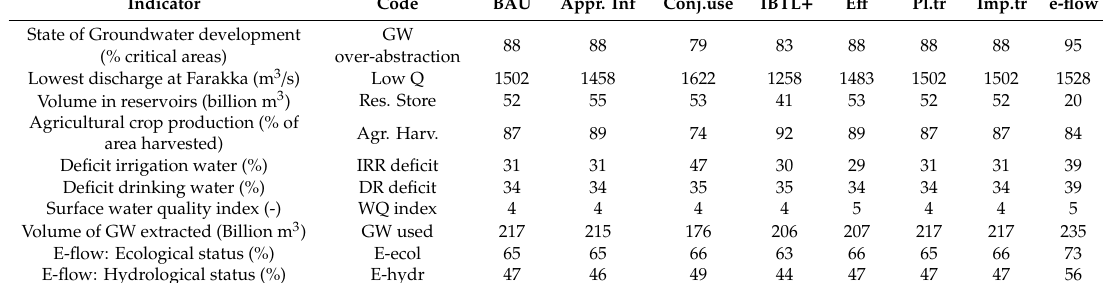
Figure 9. Basin-wide indicators for five scenarios. Values are scaled from 0 to 100, with the pristine scenario as 100). Indicator codes are explained in Table 6 and described in Table 2.